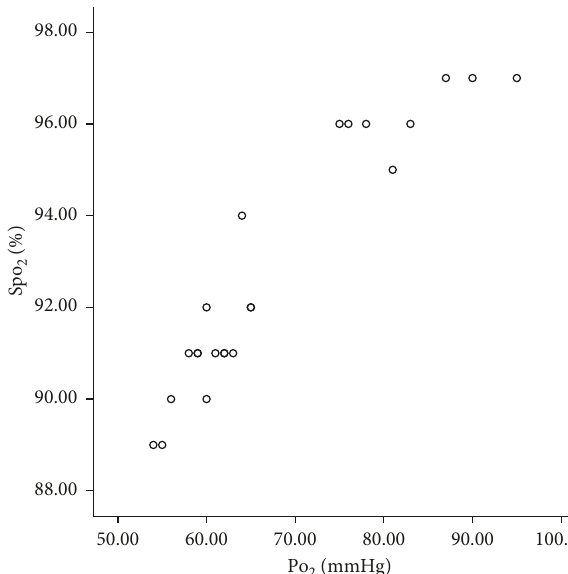
Figure 6: Association of partial arterial oxygen pressure (PO oxygen saturation (SpO 2 ) at 60minutes ( p < 0 . 001, r �